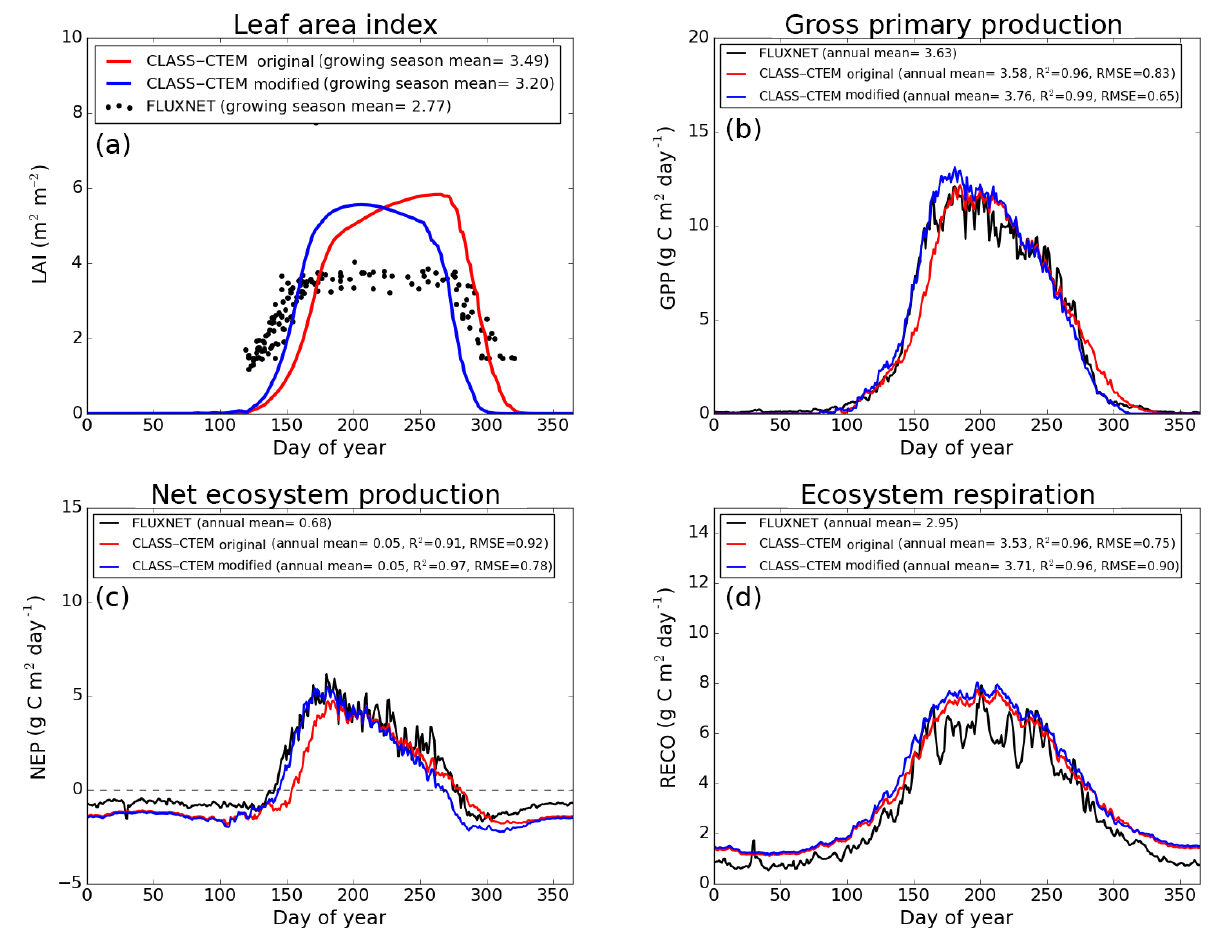
Figure 6. Observed and CLASS–CTEM-simulated averaged daily values of (a) LAI (m 2 m − 2 ), (b) GPP (gCm − 2 day − 1 ), (c) NEP (gCm − 2 day − 1 ), and (d) ecosystem respiration (gCm − 2 day − 1 ) for the US-UMB (University of Michigan Biological Reserve) FLUXNET site across all years when data are present. Legends also show the mean annual value of the quantity plotted, except for LAI, which is aver- aged over the growing season. Root-mean-square error (RMSE) and coefficient of determination ( R 2 ) are also shown for simulated values when compared to observation-based